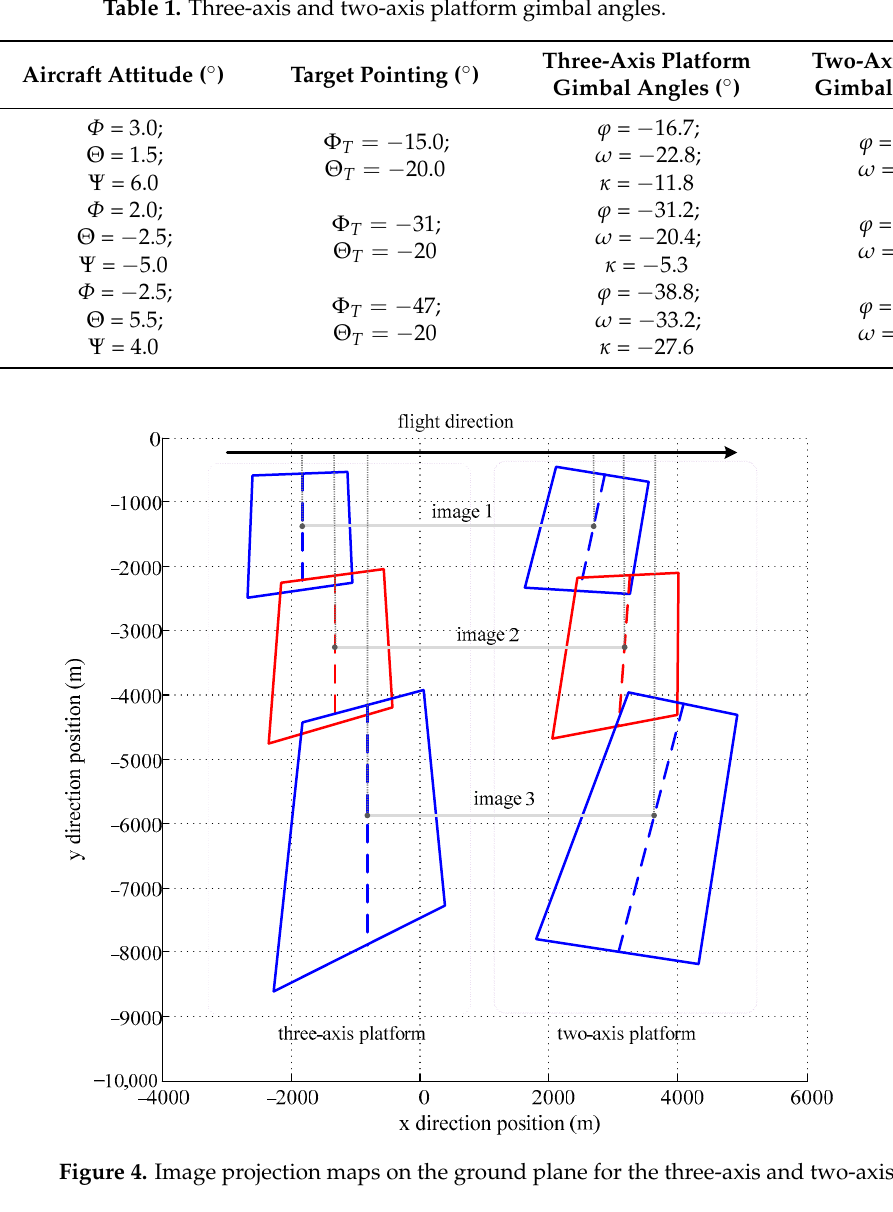
Table 1. Three-axis and two-axis platform gimbal angles.